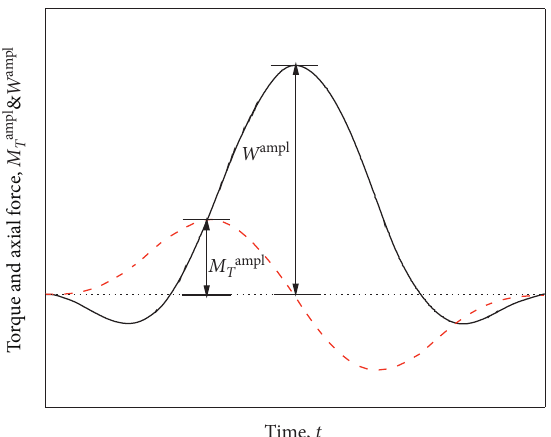
Figure 4: Loading waves.